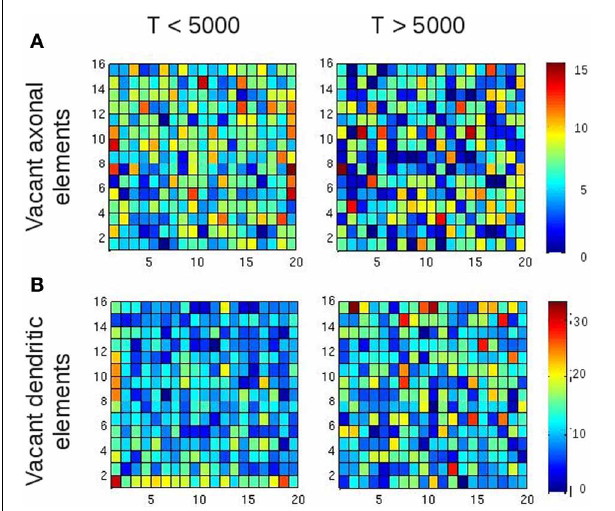
FIGURE 8 | Spatial position of vacant synaptic elements in small-world networks. The purpose of this figure is to rule out that the position of vacant synaptic elements alone gave rise to longer-ranged synaptic connections. The left column shows vacant synaptic elements accumulated over the first 5000 updates in connectivity, whereas the right column shows the accumulation of vacant synaptic elements over the following 5000 updates. Although some tendency of vacant synaptic elements being located at the borders of the network is visible, this effect is gone after 5000 updates in connectivity. So there is no bias in the distribution of vacant synaptic elements when activity reaches the homeostatic set-point, and therefore the position of vacant synaptic elements alone cannot account for the formation of longer-ranged synaptic connections for T > 5000. (A) Vacant axonal elements. (B) Vacant dendritic elements. Color scale indicates number of vacant synaptic elements per